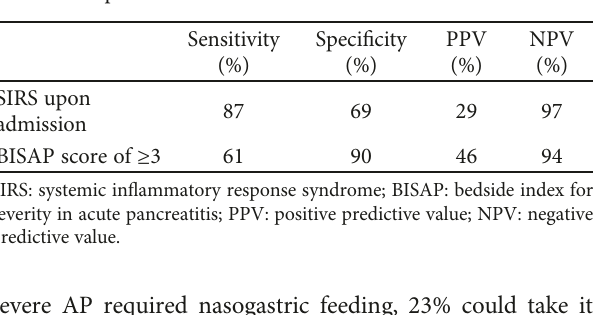
Figure 1: Severity of acute pancreatitis. Table 3: Accuracy of the two most common methods to predict severe acute